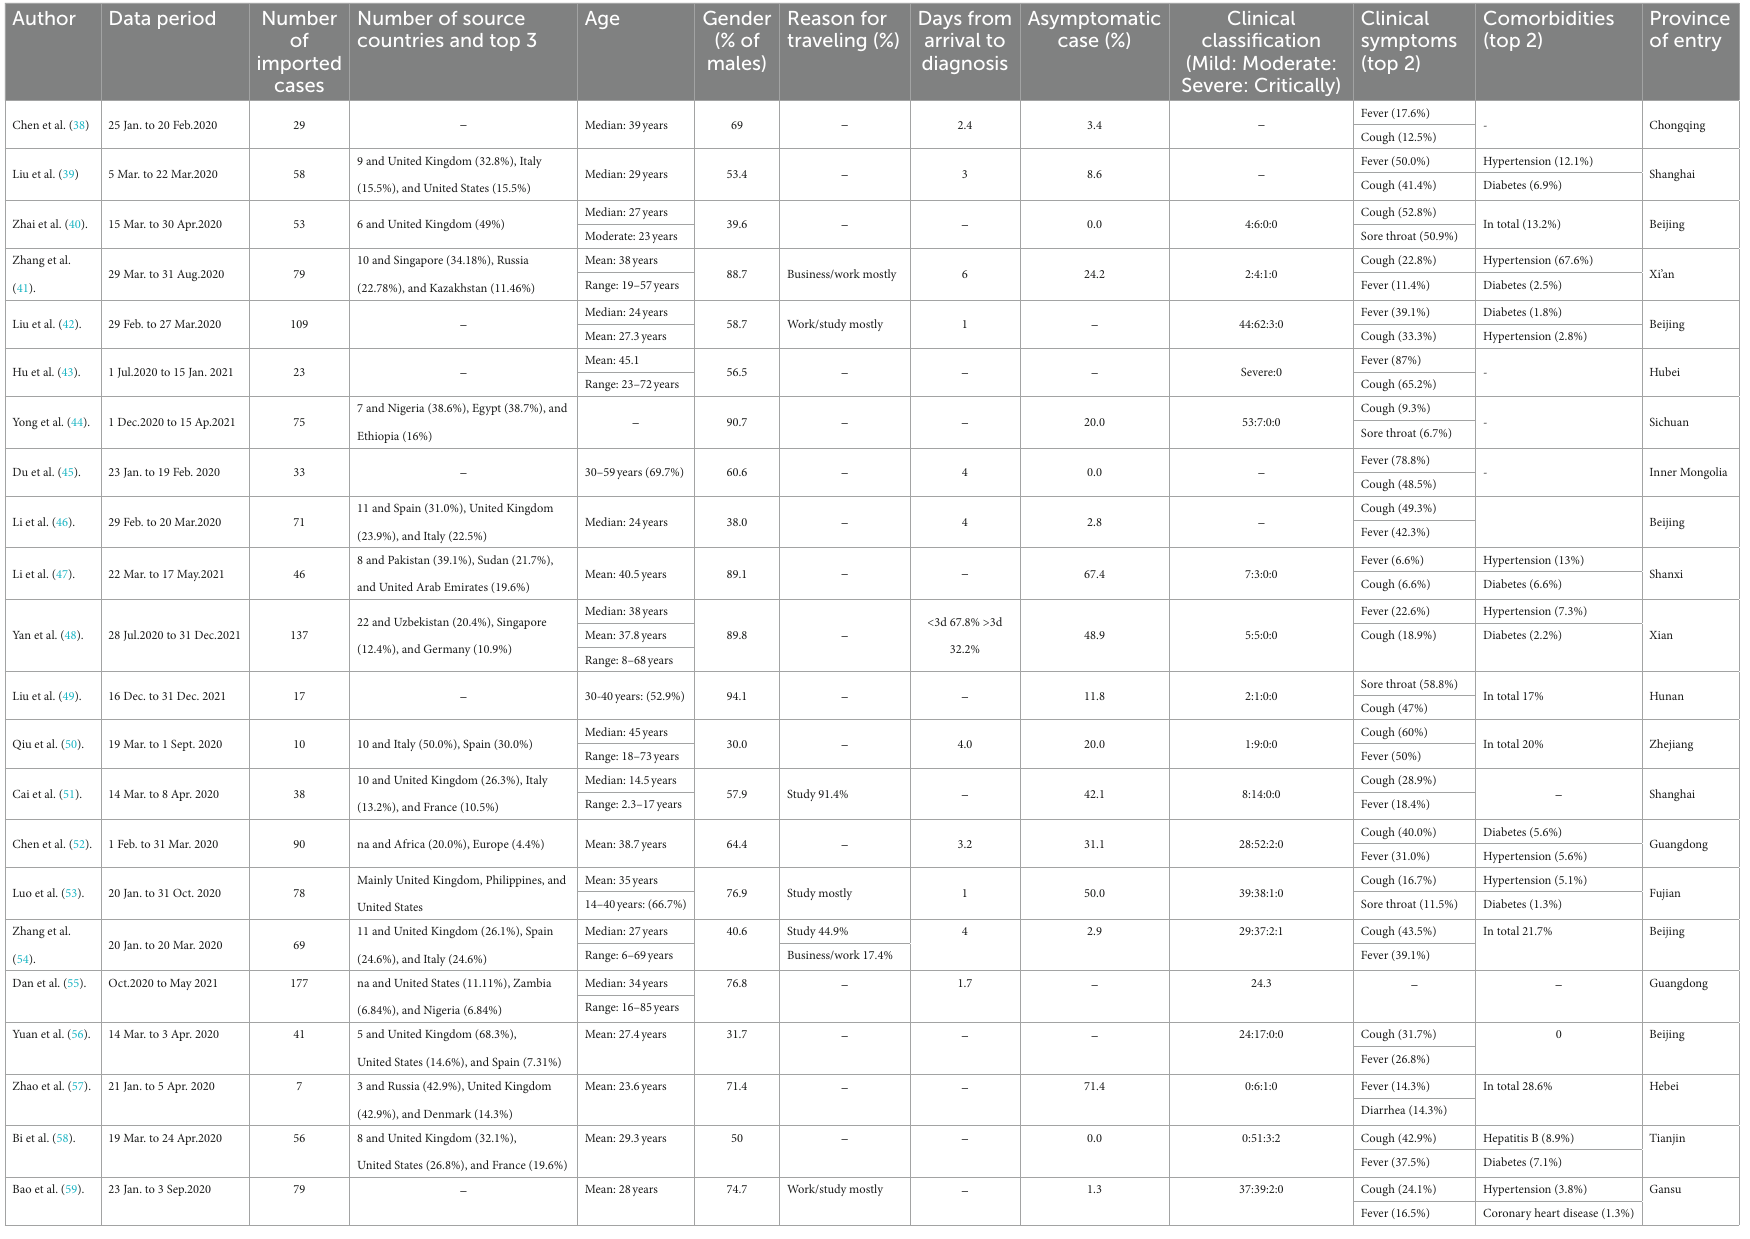
TABLE 3 Summary of 22 studies using hospital admission